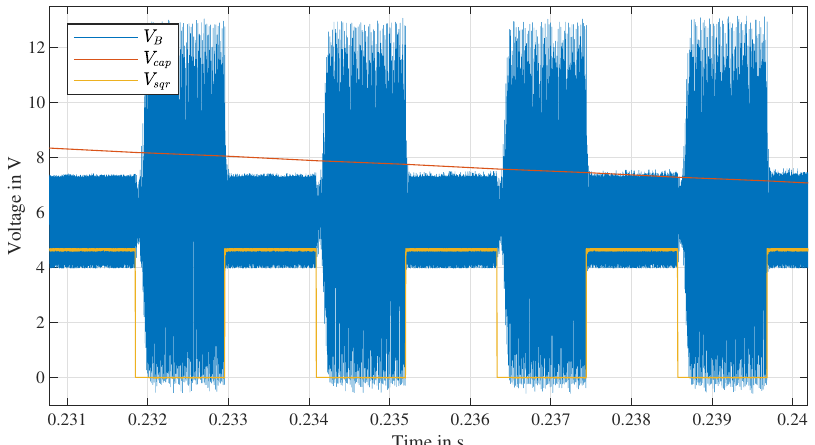
Figure 11. Simulated voltages across the capacitor C s ( V cap ), at node B ( V B ), and the signal at the gate of the JFET transistor T 1 ( V sqr ) from the transmitter circuit in Figure 9. The Colpitts oscillator reacts inversely to the switching level at its transistor.